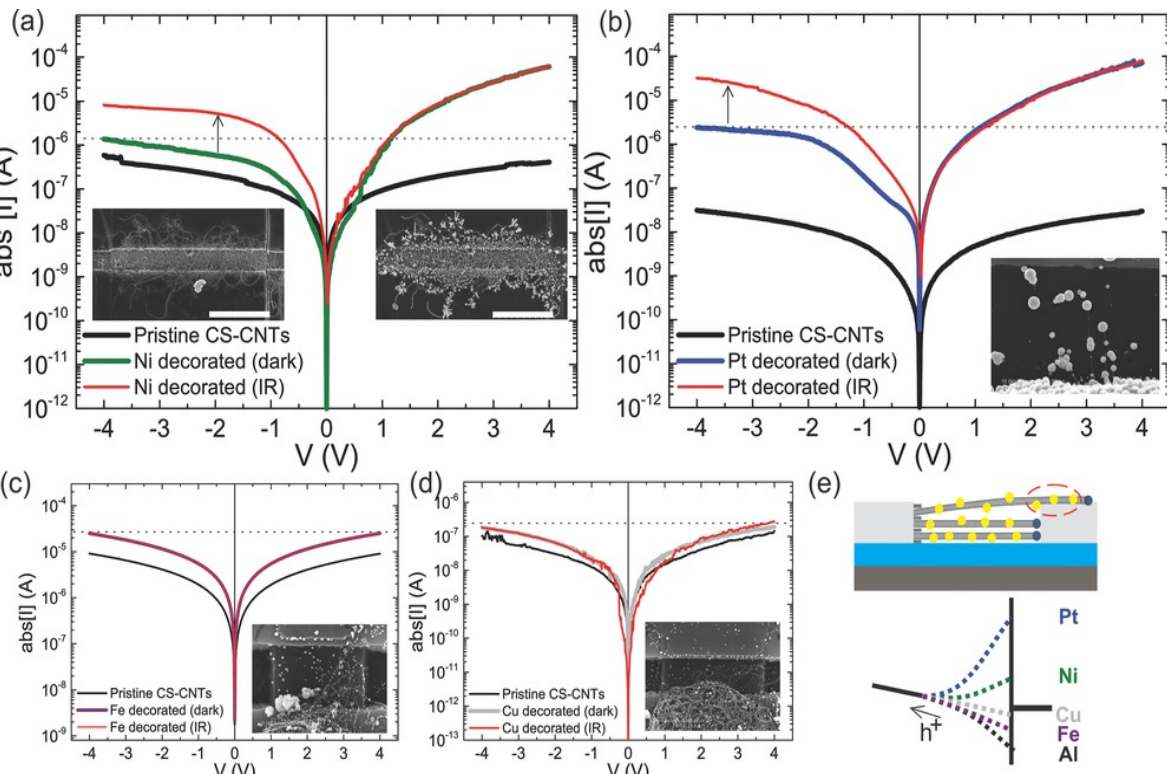
Figure 36. Lateral-PAA anodized alumina templates asymmetrically contacted obtained via an electrodeposition process. A dependence between the values of the corresponding metal NP work functions and the rectifying effect has been established in a Schottky Barrier model. ( a ) I–V curve characteristics of a CS-CNTs device before Ni decoration in the dark (black line), after Ni decoration in the dark (green line) and under IR illumination (red line). Left inset: SEM image before decoration. Right inset: SEM image after decoration. Scale bar: 20 µ m. ( b ) I–V characteristics of a CS-CNTs device before Pt decoration in the dark (black line), after Pt decoration in the dark (purple line) and under IR illumination (red line). Right inset: SEM image after decoration. Image size: 10 µ m × 5 µ m. ( c ) I–V characteristics of a CS-CNTs device before Fe decoration in the dark (black line), after Fe decoration in the dark (lilac line) and under IR illumination (red line). Right inset: SEM image after decoration. Image size: 20 µ m × 10 µ m. ( d ) I–V characteristics of a CS-CNTs device before Cu decoration in the dark (black line), after Cu decoration in the dark (grey line) and under IR illumination (red line). ( e ) Top: a sketch of a metal decorated device. The dashed ellipse shows the NPs responsible for the Schottky Barrier tuning. Down: a sketch of the corresponding energy band diagram for the different metal nanoparticles showing the tuning of the Schottky Barrier at the contact. Reprinted with permission from Ref. [14]. Copyright © 2023 WILEy-VCH Verlag GmbH & Co. KGaA, Weinheim,